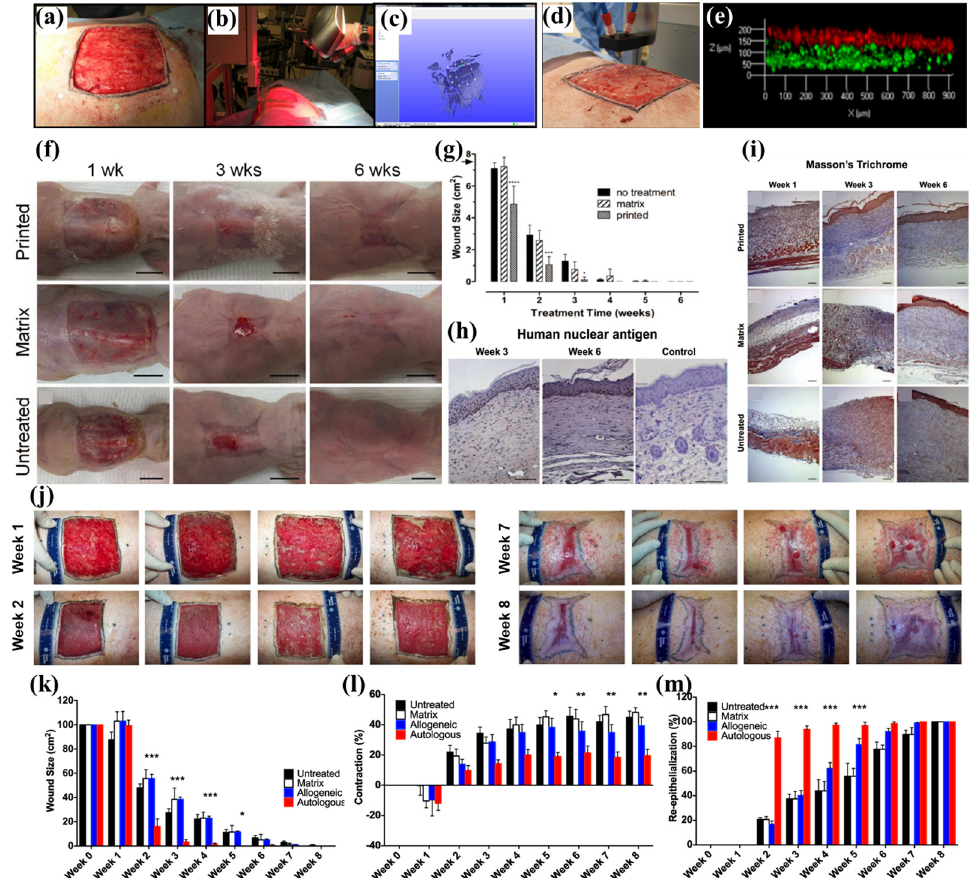
Figure 6. In situ bioprinting of autologous skin cells for healing of full-thickness wounds. ( a ) The full-thickness wound on the porcine skin. ( b ) Geometric information was obtained by 3D scanner. ( c ) Scanned data with its coordinate system. ( d ) In situ printing process. ( e ) The layering of FBs (green) and KCs (red) in the skin constructs. ( f ) Observation of wound healing on the mouse model using printed, dressing matrix, and untreated control for 6 weeks. ( g ) Size of the wound for 6 weeks. ( h ) Anti-human nucleus shows that human cells were maintained for 6 weeks. ( i ) Masson’s trichome staining showed fast re-epithelialization in the printed group compared to the dressing matrix and untreated control. ( j ) Observation of wound healing process in the porcine model. ( k ) Wound size, ( l ) contraction, and ( m ) re-epithelialization, during 8 weeks, show that the printed skins containing autologous cells induced excellent wound healing. The asterisks (*~***) refer to significant differences (* = p < 0.05; ** = p ≤ 0.01, and *** = p ≤ 0.001). The data were reproduced from Ref [105] Copyrights 2018 Nature Publishing Group.